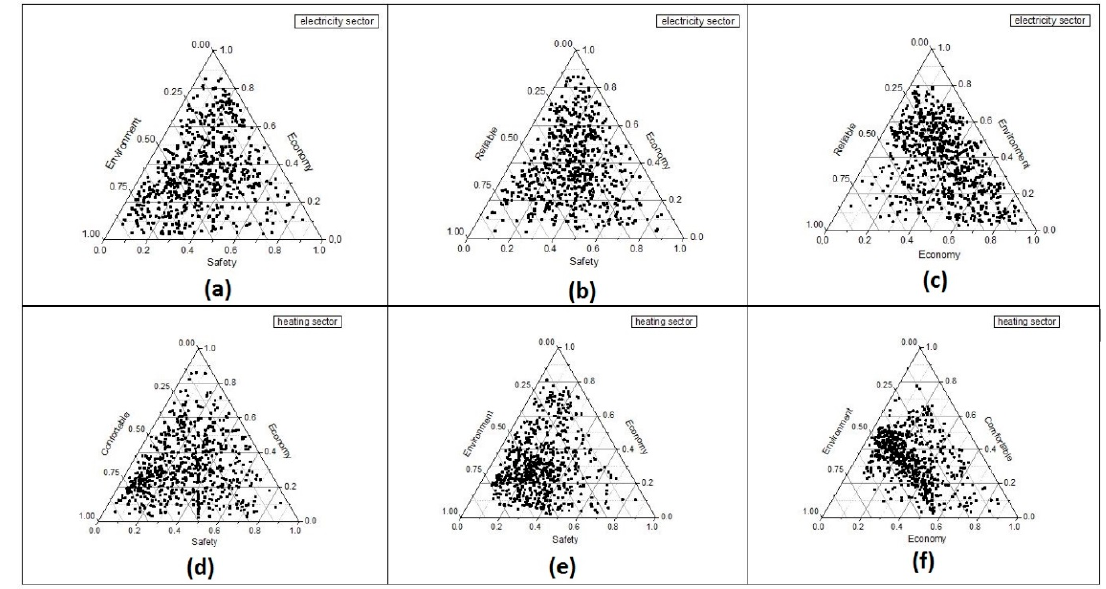
Figure 5. The distribution of the individual importance weights assigned to the main criteria on ternary plots.